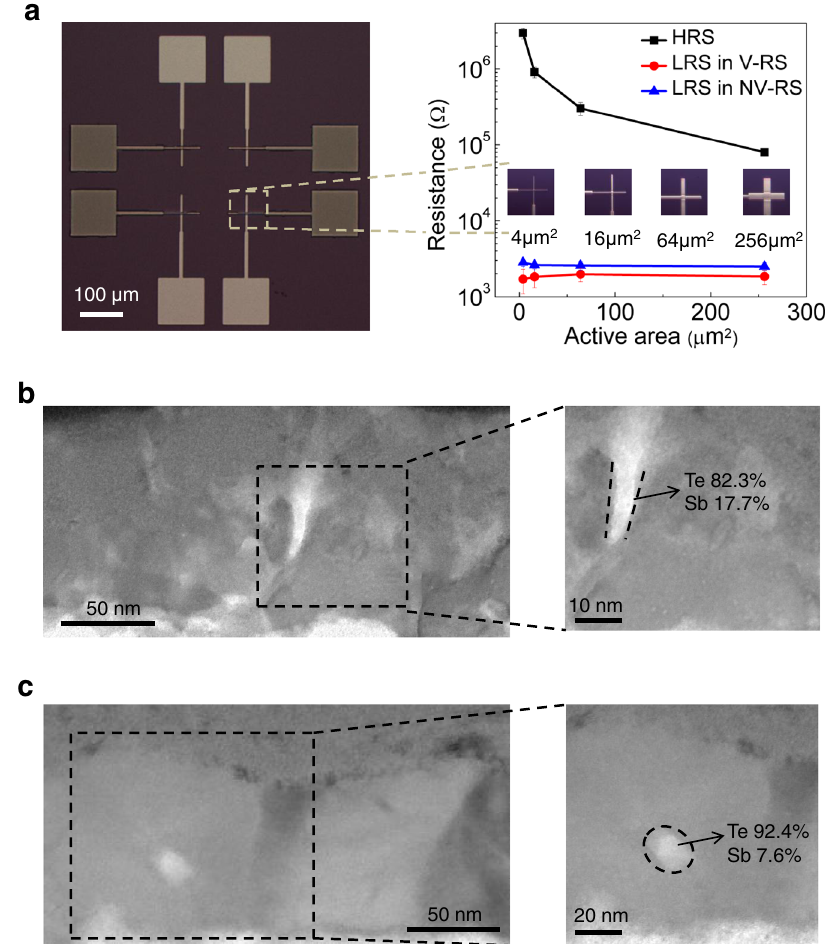
Fig. 2 Electrode size-independent fi lamentary conduction and fi lament observation. ( a ) Dependence of the resistance on the electrode area measured for both the devices in the NV-RS mode and V-RS mode. Error bar: resistance distribution obtained from three randomly selected devices. Cross-sectional TEM images of the TST device after ( b ) NV-SET switching and ( c )